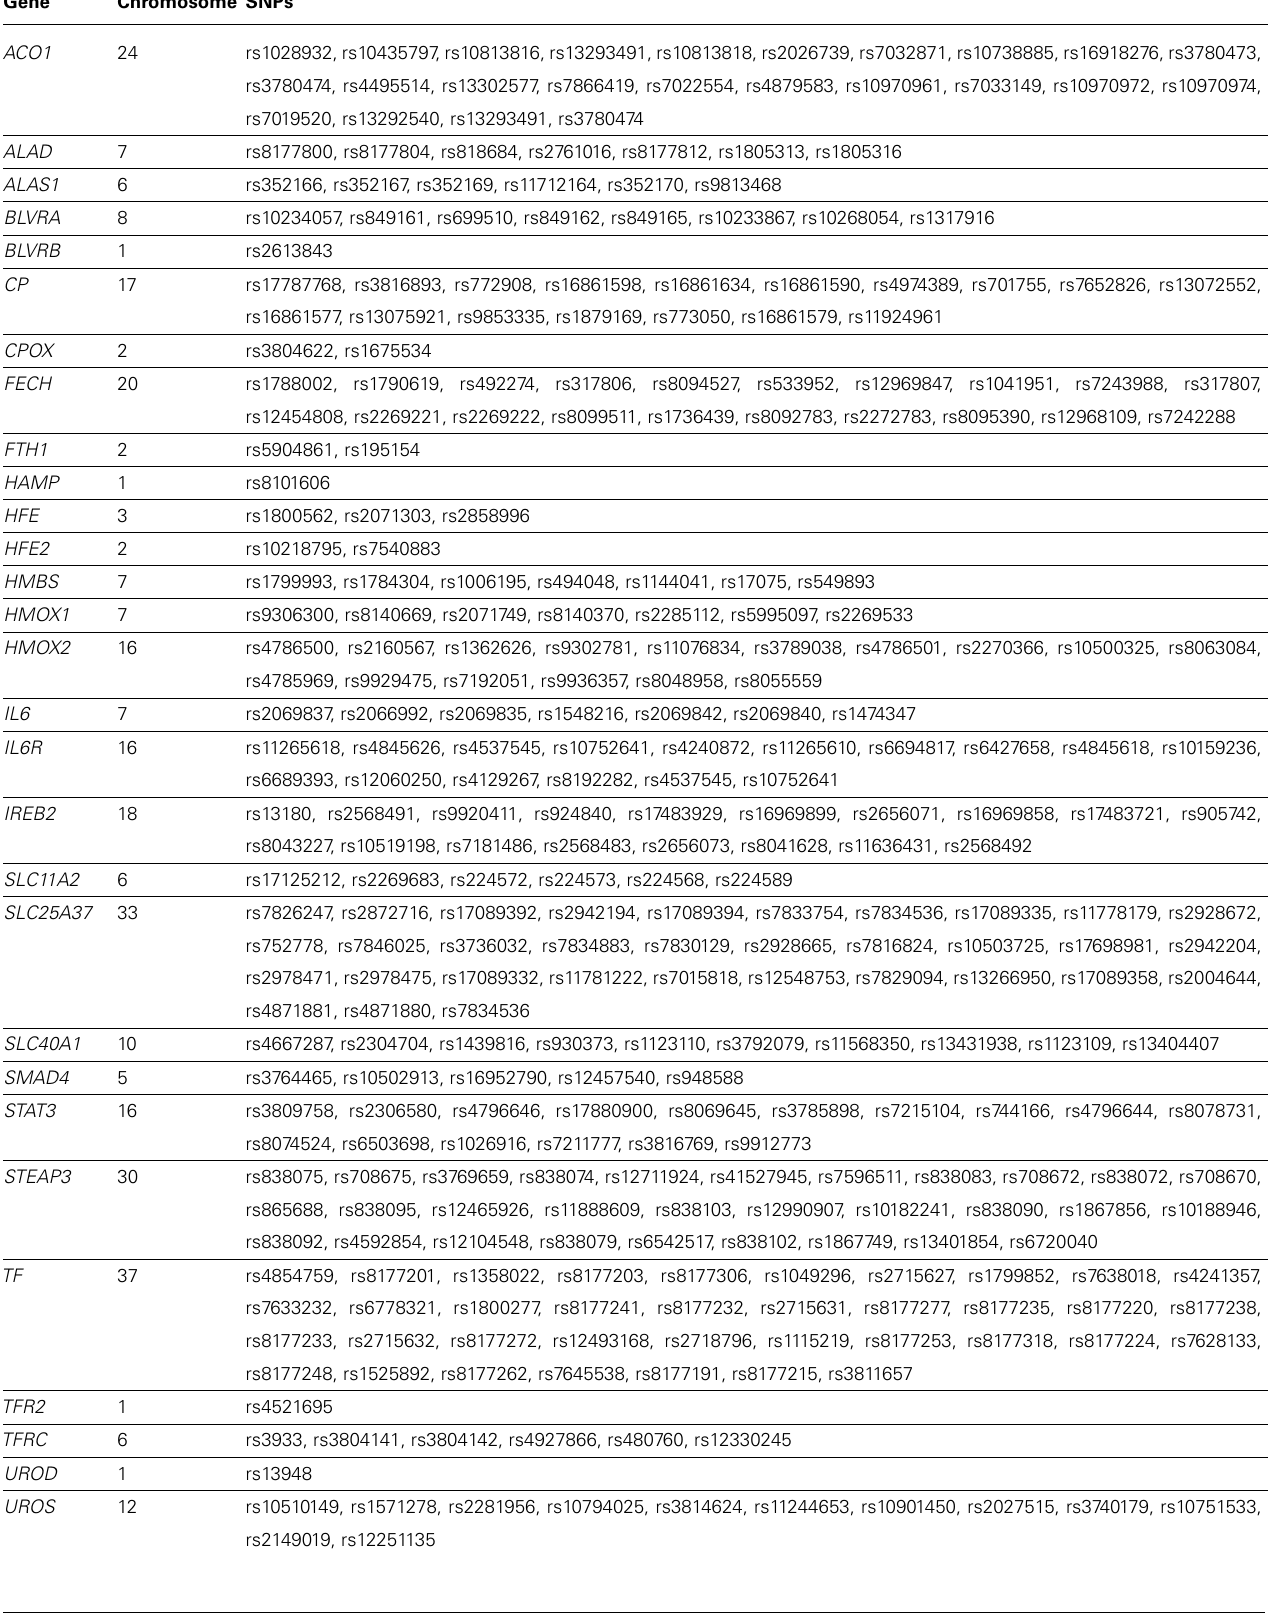
Table 2 | Genes and single nucleotide polymorphisms (SNPs) in the heme iron metabolic pathway on theAffymetrix 6.0 array that passed quality